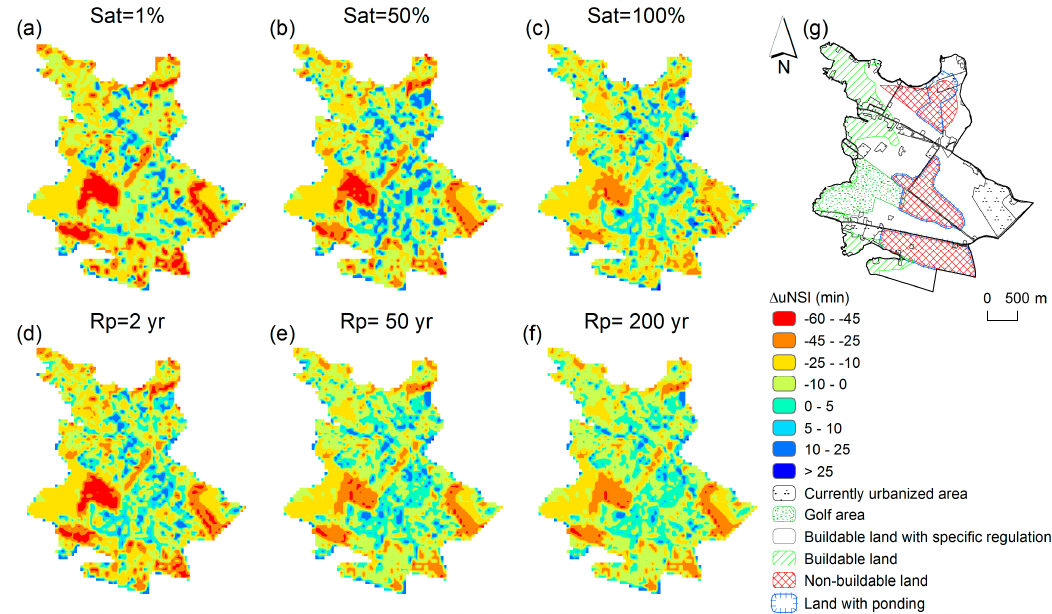
Figure 11. Local difference in uNSI between 2010 and 1982. A negative sign indicates a faster response of the network in 2010. Differences are evaluated considering all hyetographs and ( a – c ) all return periods averaged for each specified antecedent soil moisture condition (Sat); ( d – f ) all saturation conditions averaged for the specified return period (Rp); and ( g ) displays some characteristics of the urbanisation settings and regulations for the area [27].